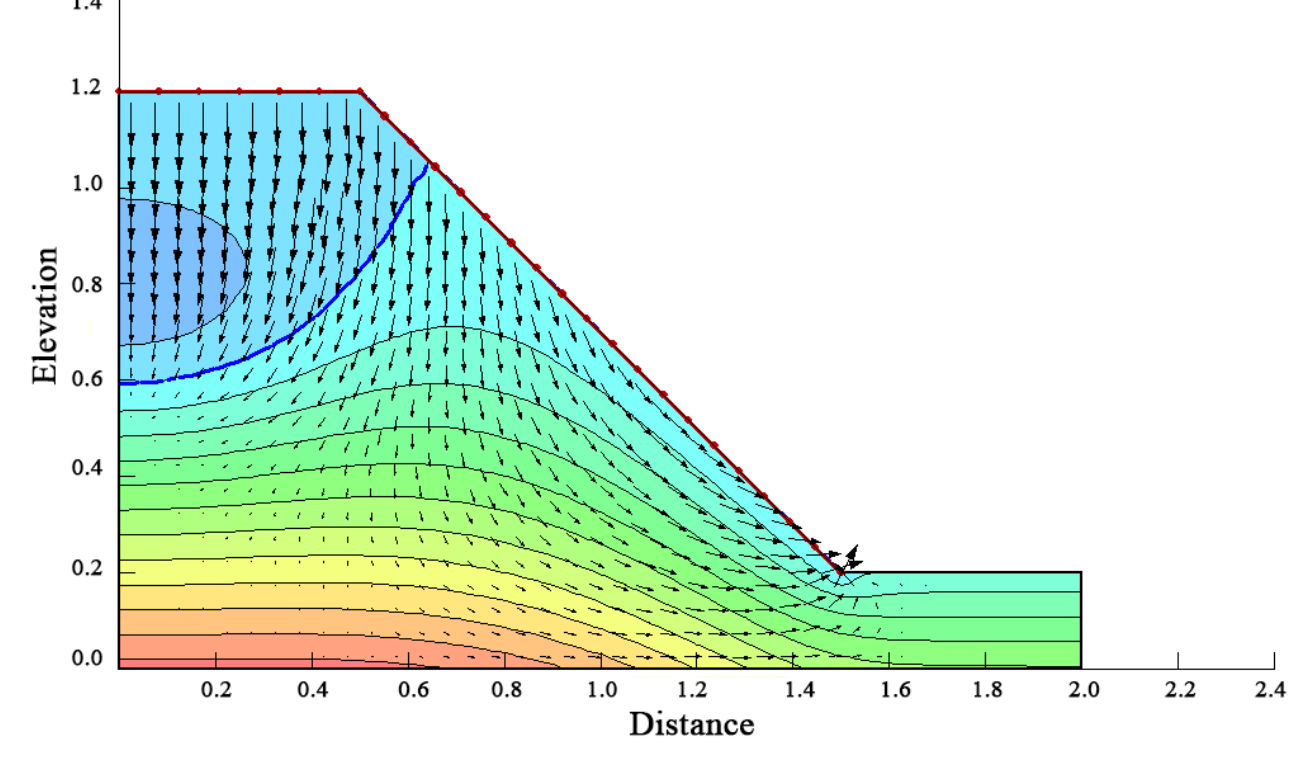
the base of slope below the phreatic line. The location of the phreatic line was 36 mm/h on the surface of a slope that was approximately 0.5 m. The location of the maximum water head at 36 mm/h was below the phreatic line, and the location of the minimum water